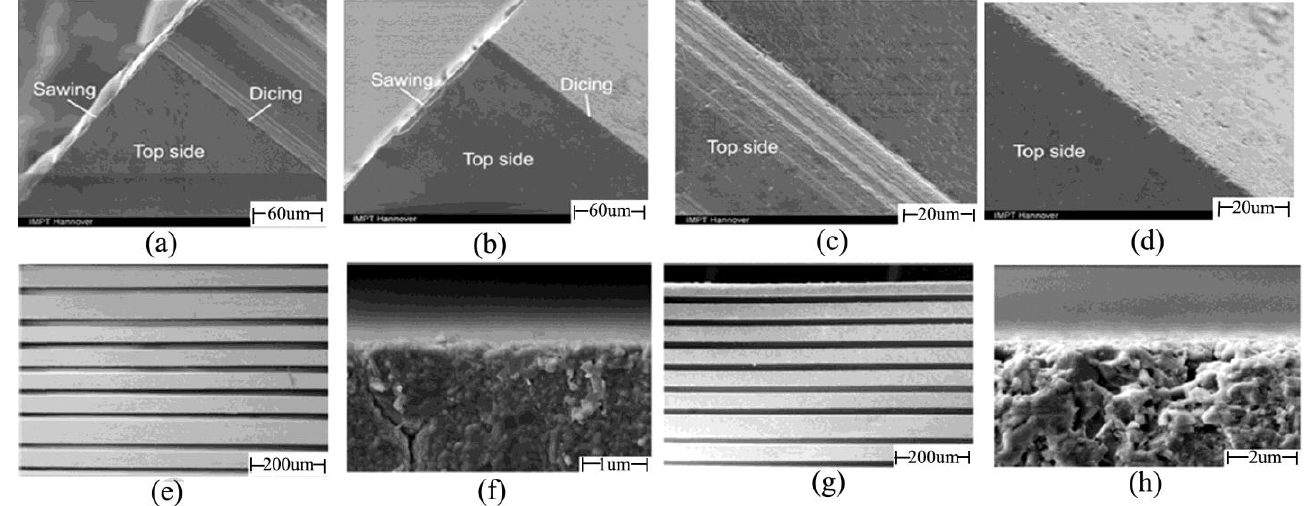
Figure 23. Comparison of machining techniques for ( a ) monocrystalline and ( b ) ceramic substrates; SEM micrographs of edges after dicing of ( c ) monocrystalline and ( d ) ceramic substrates; for alu- mina, ( e ) channels generated after the surface grinding; ( f ) profile of the cross-section roughness; ( g ) channel generated on the surface after the dicing process; ( h ) profile of roughness measured on the channel [45,114]. Adapted with permission from Ref. [114]. 2011, Elsevier.